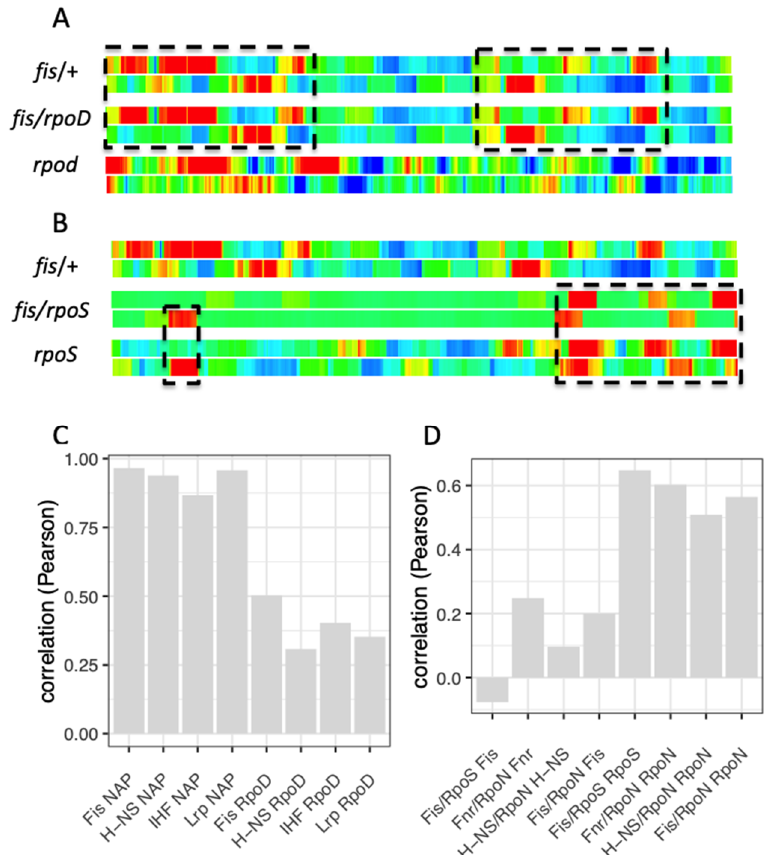
Figure 5. Correlation between the genomic organization of regulons and couplons. ( A ). Genomic organisation of the FIS and RpoD regulons and FIS/RpoD couplons. The circular chromosome is divided into the right (top) and left (bottom) replichores. The origin of replication is situated on the left, the terminus on the right. The red and blue colors respectively indicate a significant enrichment (Z score > 2) and depletion (Z score < − 2) in relative frequency of the regulon or FIS/RpoD couplon genes. Note that the pattern of FIS/RpoD couplons is largely coinciding with that of the FIS regulon (dashed box). ( B ). Genomic organisation of the FIS and RpoS regulons and FIS/RpoS couplons. Note that the pattern of FIS/RpoS couplons largely coincides with that of the RpoS regulon (dashed box). Enrichment of regulon genes was determined by comparison of the number of regulon genes within the 100 kb window with the number of regulon genes within random samples with the same number of genes. Z-scores were derived from 10.000 random samples. ( C ). Pearson correlations (ordinate) between the genomic organisation of NAP/RpoD couplons and cognate NAP regulons (indicated on abscissa, the first four columns in the graph. FIS NAP means FIS/RpoD couplons compared to FIS regulon, H-NS NAP means H-NS/RpoD couplons compared to H-NS regulon and so on); the last four columns in the graph show Pearson correlations between the genomic organisation of NAP/RpoD couplons and RpoD regulon (as indicated on abscissa: FIS RpoD means FIS/RpoD couplons compared to RpoD regulon, H-NS RpoD means H-NS/RpoD couplons compared to RpoD regulon and so on); Note the high positive correlation between NAP/RpoD couplons and NAP regulons compared to that between NAP/RpoD couplons and RpoD regulon. ( D ). Pearson correlations (ordinate) between the genomic organization of NAP/ASF couplons and NAP regulons (the first four columns in the graph); Pearson correlations between NAP/ASF couplons and ASF regulons (the last four columns in the graph). Note the high positive correlation between NAP/ASF couplons and ASF regulons. Correlation of the spatial distribution was determined by Pearson correlation of the Z-scores (indicated by rainbow colors along the chromosome in A and B and in Supplementary Figures